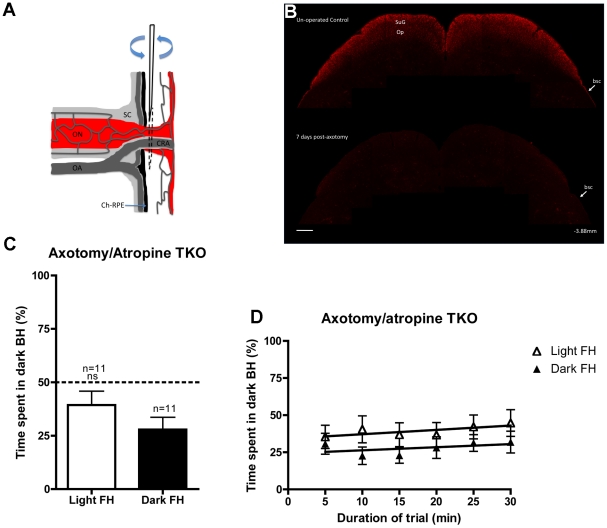
Axotomy abolishes the atropine-induced light aversion response in TKO mice.(A) Diagramatic illustration of the axotomy technique (image modified from [75] ), a swift back and forth movement of the needle severs both the optic nerve and central retinal artery. (B) Immunoreactivity for calretinin positive retinal afferents (red) is abolished in the superficial gray (SuG) and the optic nerve (Op) layers of the superior colliculus of a bilaterally axotomised TKO (bottom) compared to an unoperated contol (top). Collicular sections are −3.88 mm from bregma [76], scale bar is 200 µm. (C) Behavioural aversion to light in atropine-treated TKO mice is abolished in bilaterally axotomised animals. (D) Time spent in the dark back half (BH) of the arena over the course of the 30-minute trial. White triangles, from trials when the front-half (FH) is in light, black triangles when the FH is in darkness. Abbreviations: bsc, brachium of the superior colliculus; Ch-RPE, choroid retinal pigment epithelium; CRA, central retinal artery; ns, not significant; OA, ophthalmic artery, ON, optic nerve; Sc, sclera.